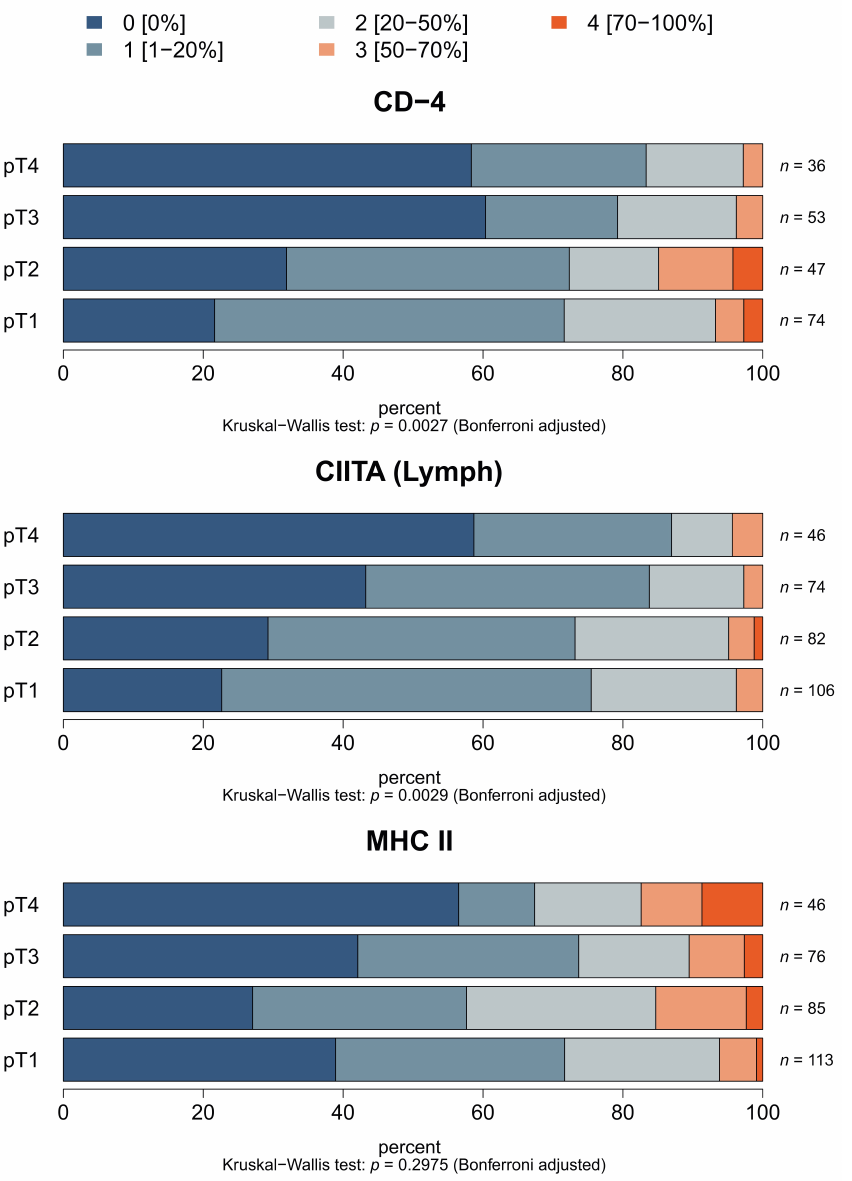
Figure 5. Correlation of HLA class II APM expression and immune cell infiltration with tumor staging. The staining of the TMA was performed as described in Materials and Methods. Expression of CIITA in lymphocytes and CD4 + T-cell infiltration correlated to pT stages of tumor samples. Furthermore, for comparison of the prognostic relevance of HLA class II APM com- ponent expression, in silico analyses of TCGA data were performed by using datasets from 234 high and 234 low HLA class II APM component expressors. As shown in Figure 6, the HLA class II APM high patient group has a significantly increased overall survival (OS) compared to patients with HLA class II APM low expression.